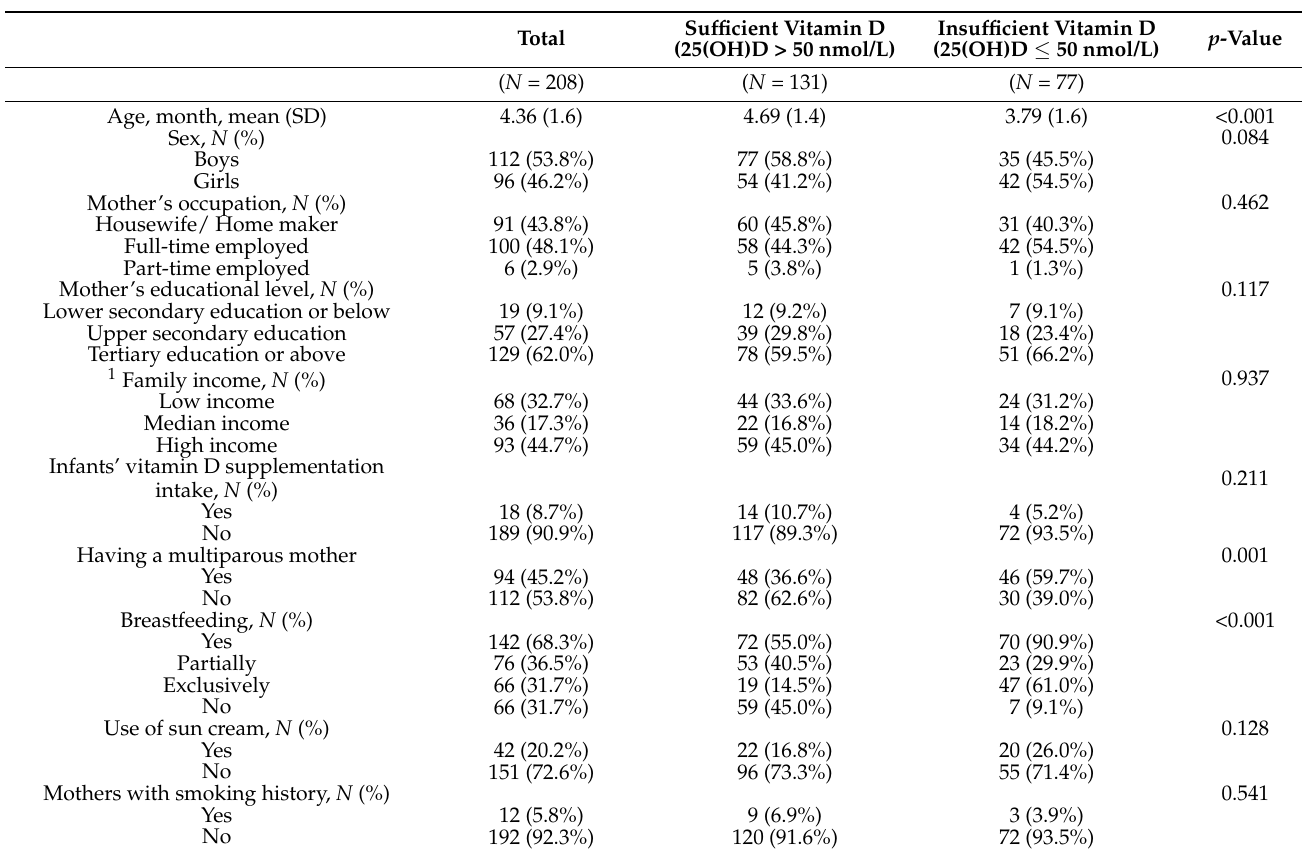
Table 1. Demographics of the